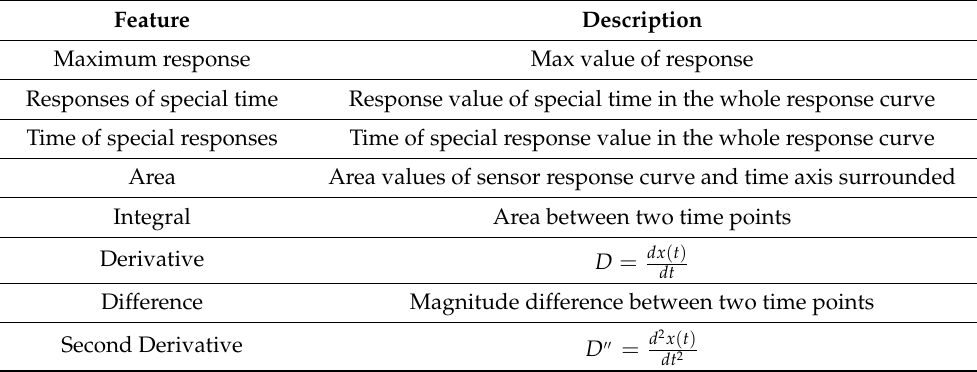
Table 1. Summary of commonly used features extracted from time-response curves.